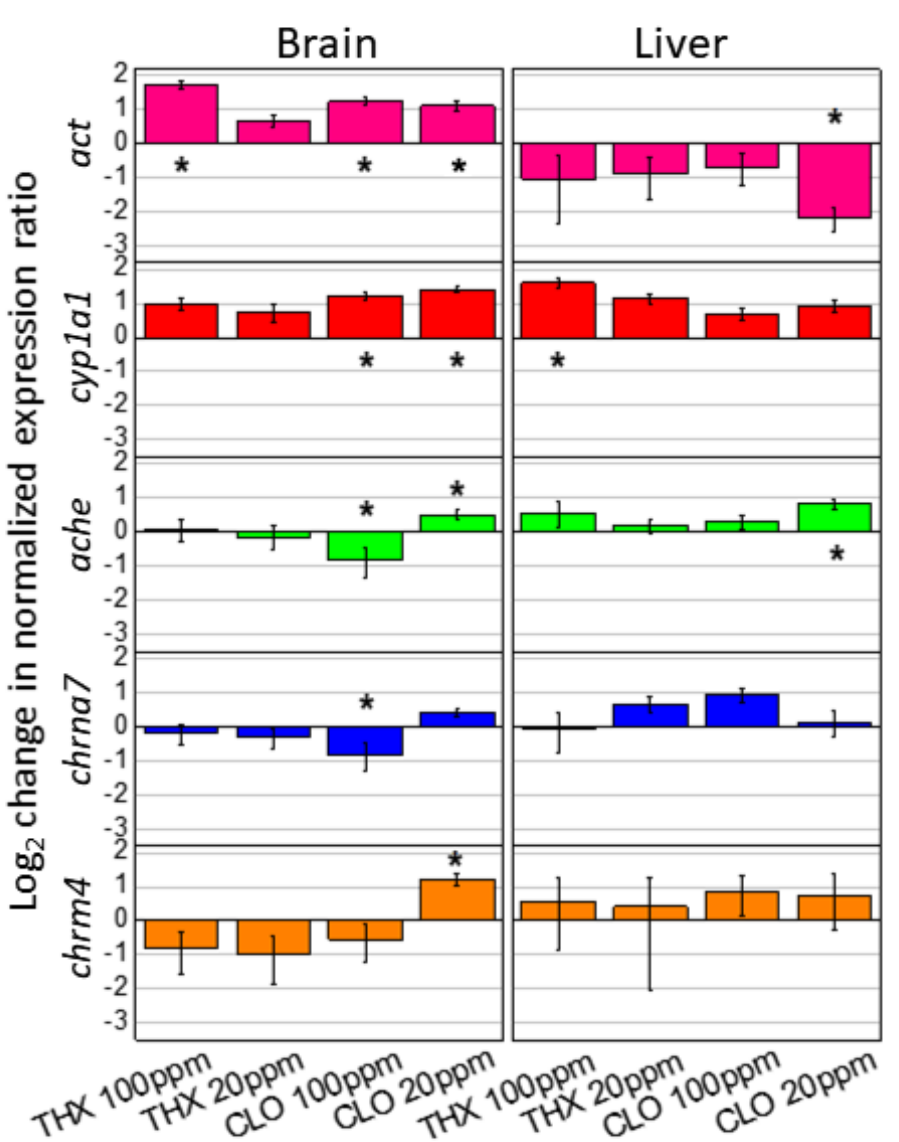
Figure 6. Gene expression levels of target genes muscarinic acetylcholine receptor 4 ( chrm4 ), nicotinic acetylcholine receptor subunit α 7 ( chrna7 ), acetylcholinesterase ( ache ), cytochrome P450 ( cyp1a1 ), and actin ( act ) in Xenopus laevis tadpole liver and brain tissues following exposure to thiamethoxam (THX) and clothianidin (CLO) at 20 and 100 ppm, or low and high, respectively, at 44 days. Target gene expressions were normalized to those from tadpoles in the control neonicotinoid-free treatment by using geometric means of both odc and gapdh reference genes; expression of chrm4 was normalized to odc only. Asterisks denote values differing significantly from the pesticide-free treatment per tissue type.